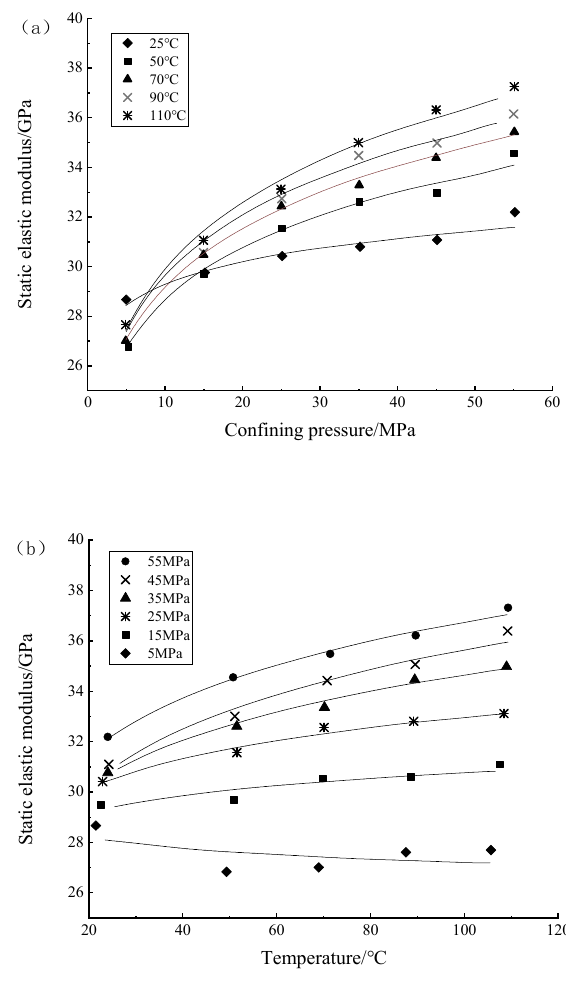
Figure 3. Variation in static elastic modulus of specimen #5 under the conditions of different con- fining pressures and temperatures: ( a ) variation in static elastic modulus with confining pressure; ( b ) variation in static elastic modulus with temperature .